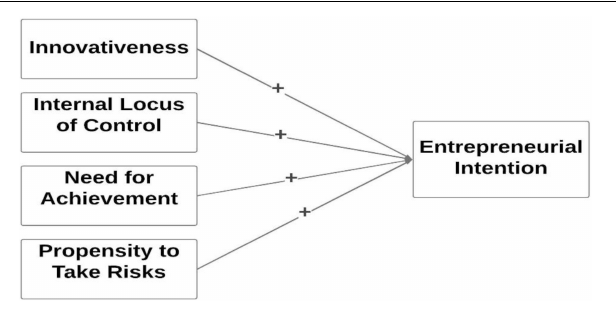
FIGURE 1 | Conceptual model. Source: Author